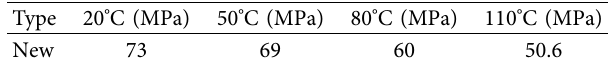
Table 5: Compressive strength of the anchoring agent in different temperature